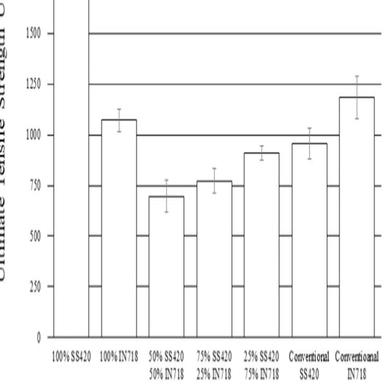
Ultimate tensile strength of all laser-DED processed compositions and conventional samples.